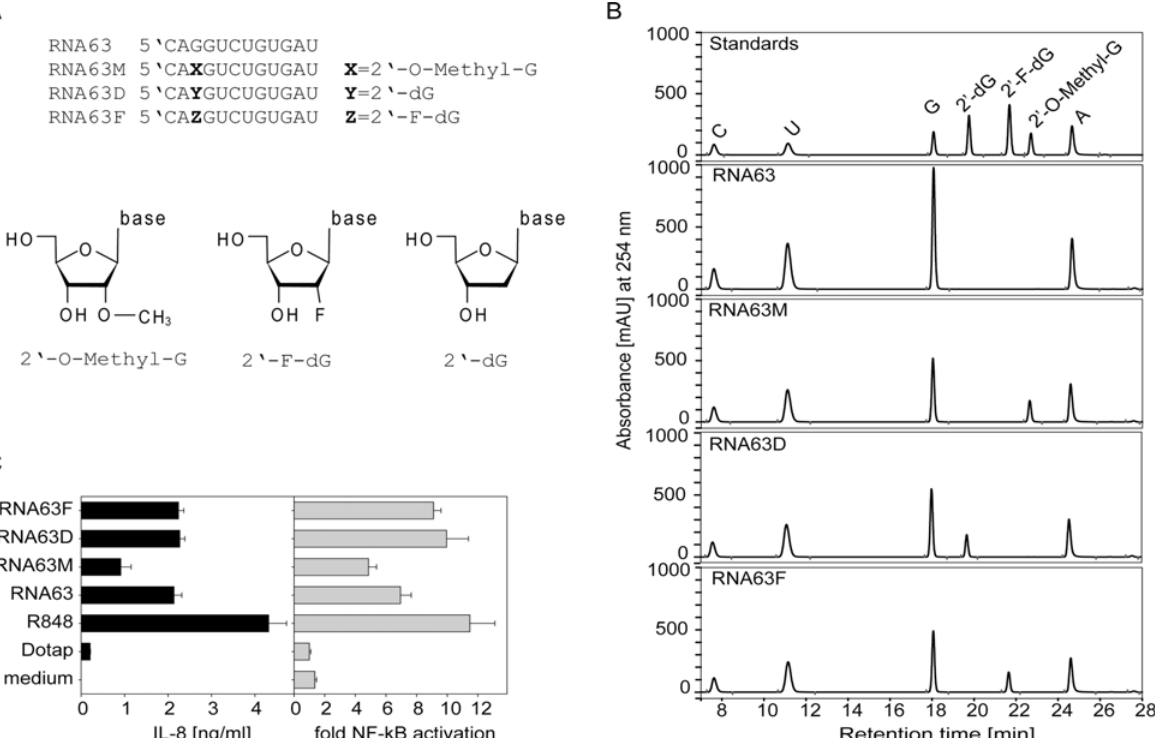
Fig 2. Nucleoside composition of non- and modified synthetic ORN and their TLR8-dependent immunostimulatory potential. (A) Sequence of ORNs used and visualized image of ribose modifications. (B) HPLC analysis of P1 nuclease and phosphatase treated synthetic ORN (RNA63, RNA63M, RNA63D, RNA63F) and corresponding standard nucleosides. (C) HEK-TLR8 cells were stimulated with ORNs as indicated (20 μ g/ml RNA63 variants and 5 μ g/ml R-848) and 1,5 μ M poly-dT. IL-8 secretion or NF-kB activation was measured by ELISA or luciferase assay. One representative experiment of at least three independent experiments is shown (n = 2 ± SD).